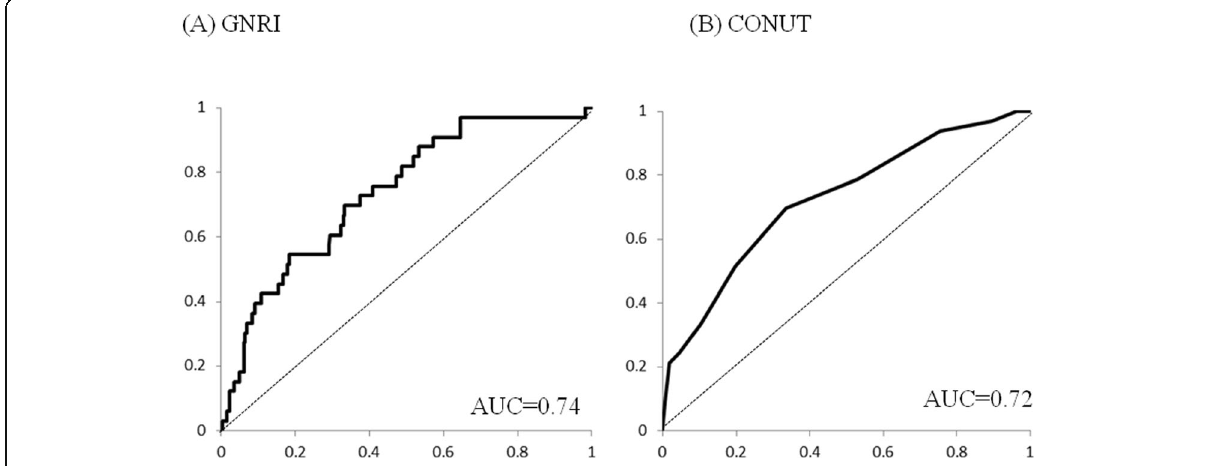
Fig. 2 The area under the receiver operating characteristic curve (AUC) to predict the 180-day mortality for each risk model is shown. The AUC values were 0.74 for the GNRI ( a ) and 0.72 for the CONUT ( b